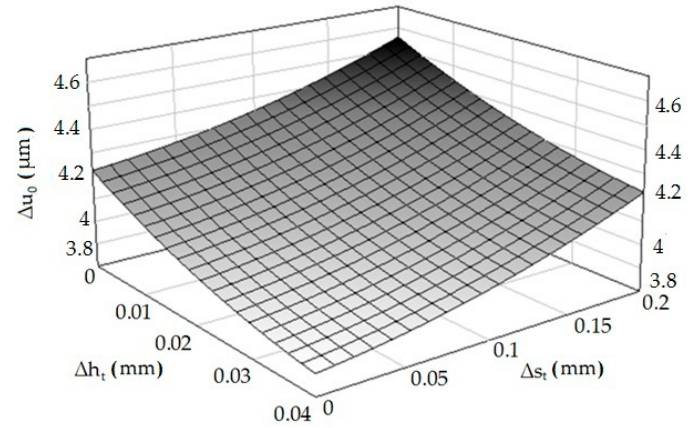
Figure 7. Dependence of the material elastic recovery after burnishing ( Δ u 0 ) from the deviations of height ( Δ h t ) and distance ( Δ s t ).